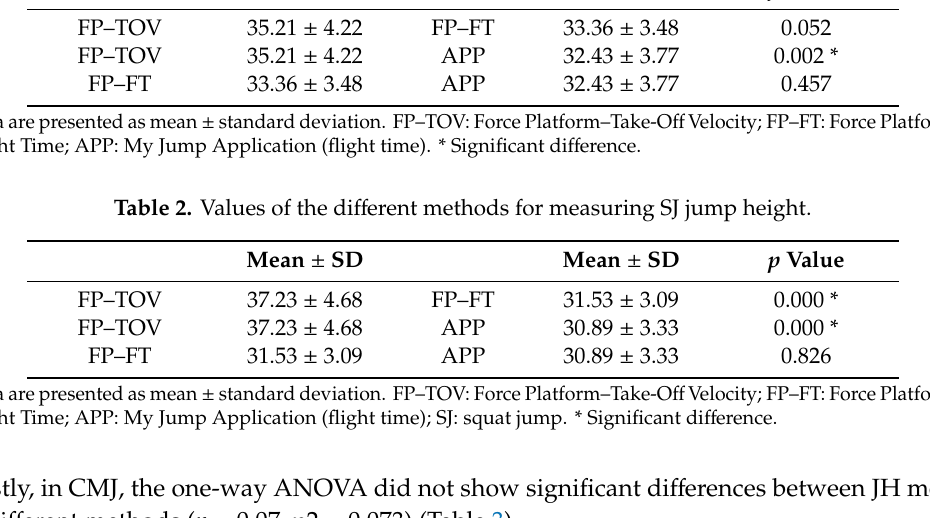
Table 1. Values of the di ff erent methods for measuring jump height combining CMJ and SJ. Mean ± SD